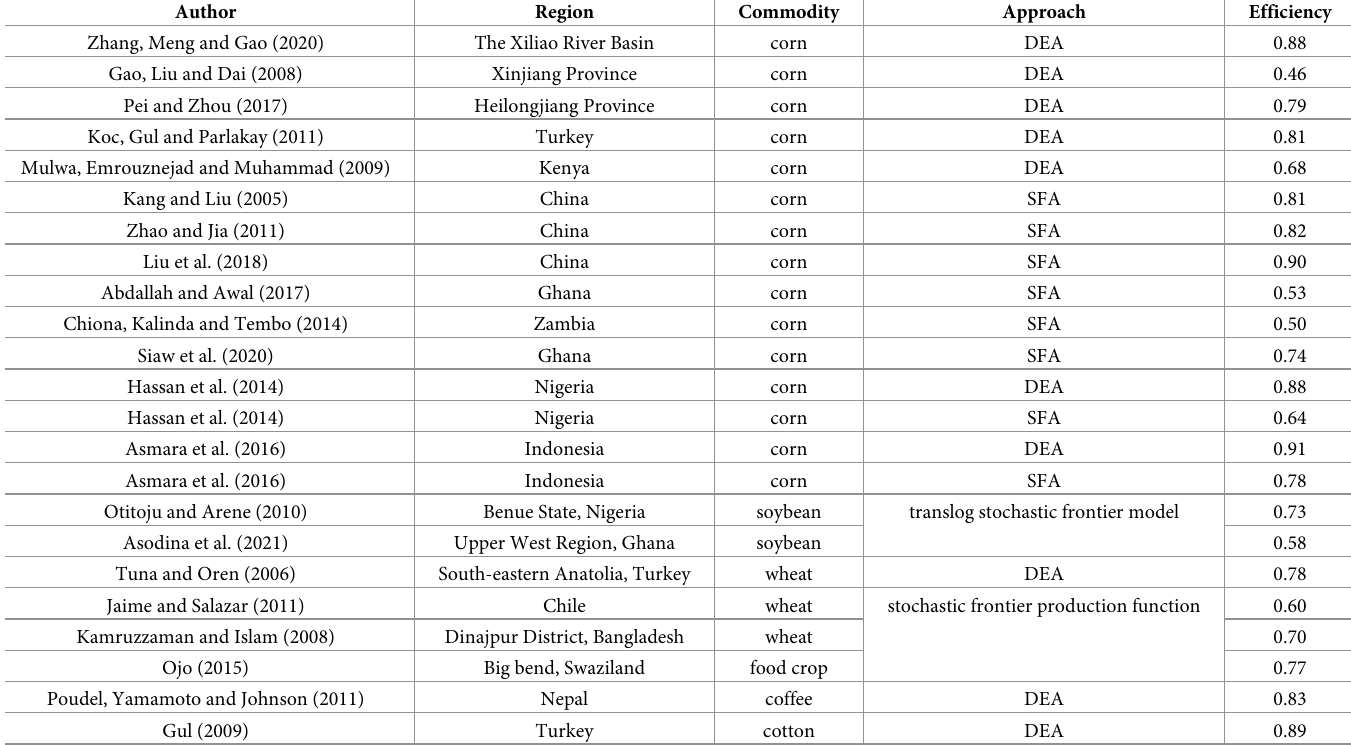
Table 1. Technical efficiency of agricultural commodities in various regions and measuring